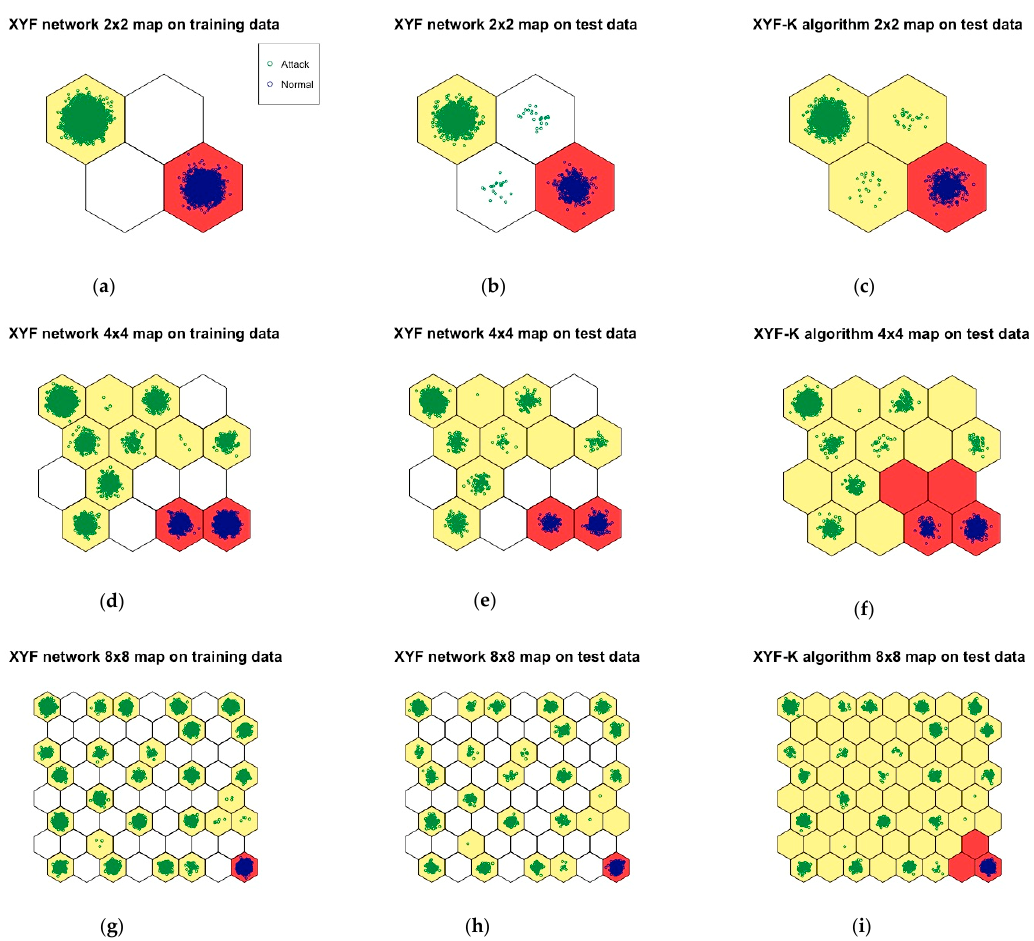
Figure 3. XYF network and XYF-K algorithm on the different neurons map sizes for the DoS dataset. ( a ) XYF network 2 × 2 map on training data; ( b ) XYF network 2 × 2 map on test data; ( c ) XYF-K algorithm 2 × 2 map on test data; ( d ) XYF network 4 × 4 map on training data; ( e ) XYF network 4 × 4 map on test data; ( f ) XYF-K algorithm 4 × 4 map on test data; ( g ) XYF network 8 × 8 map on training data; ( h ) XYF network 8 × 8 map on test data; ( i ) XYF-K algorithm 8 × 8 map on test data.